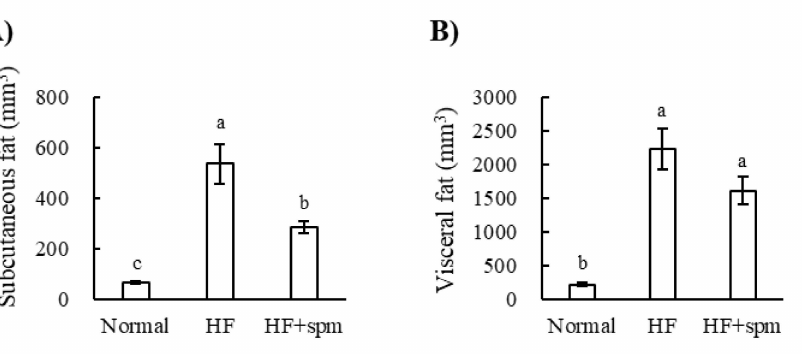
Figure 4. Effect of Spm on the ingestion fat volume scanned by micro-CT system: ( A ) Subcutaneous fat; ( B ) Visceral fat. Data are shown as means ± S.E. Tukey’s test, p < 0.05. Values in the same figure not sharing a common letter avove the bar are significantly different one